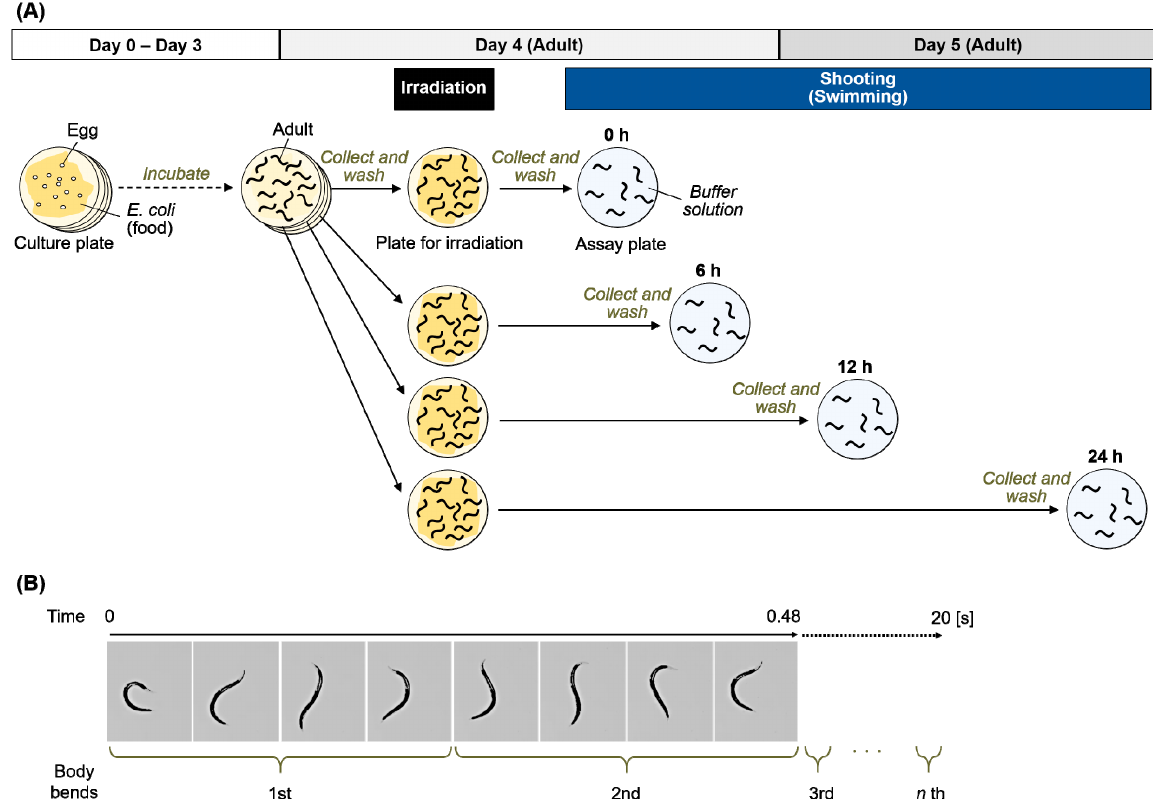
irradiated worms at 3 kGy, respectively. Error bar indicates SEM. The data were analyzed by the Student’s t -test. * indicates p- value < 0.05, significantly different from 0